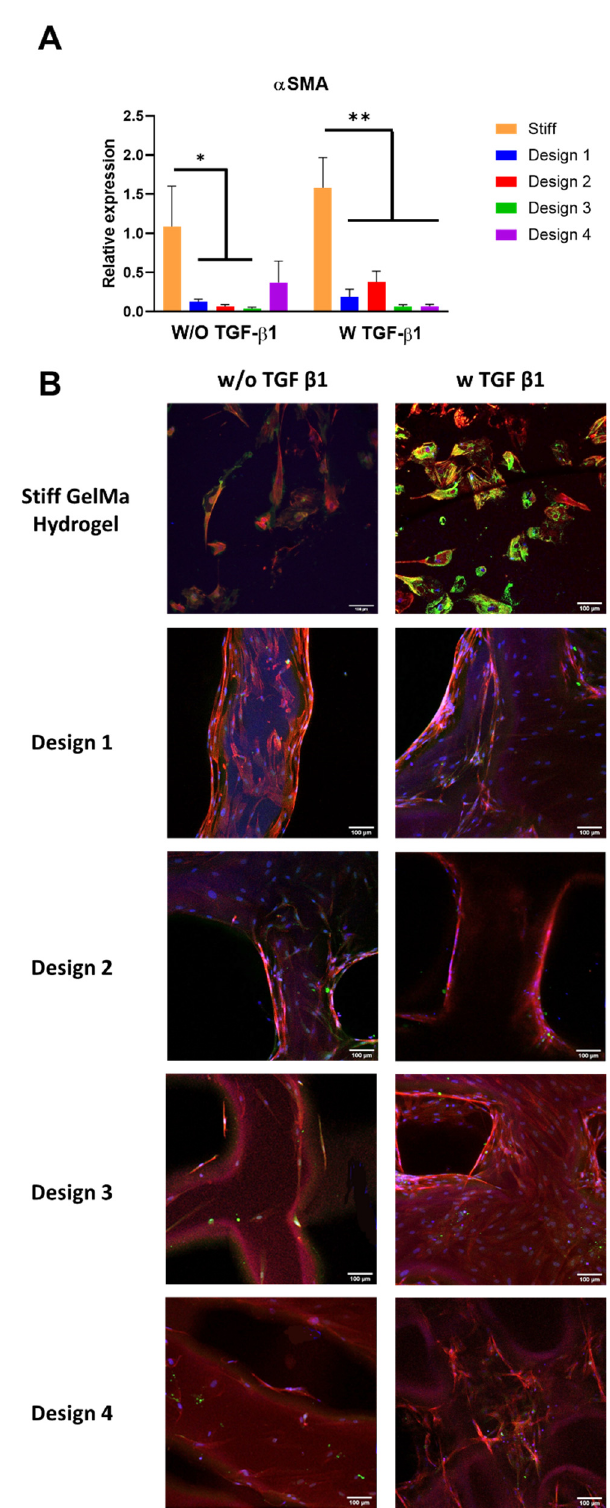
Figure 9. ( A ) Gene expression of α SMA in the 3D-printed scaffold design range compared with the stiff GelMA hydrogel. * p < 0.05 compared to the stiff GelMA hydrogel in the absence of TGF- β 1; ** p < 0.05 compared to the stiff GelMA hydrogel in the presence of TGF- β 1. ( B ) α SMA protein expression in the 3D-printed scaffold design range compared to the stiff GelMA hydrogel. DAPI (blue), phalloidin (red) and α SMA (green). Scale bar = 100 µm.